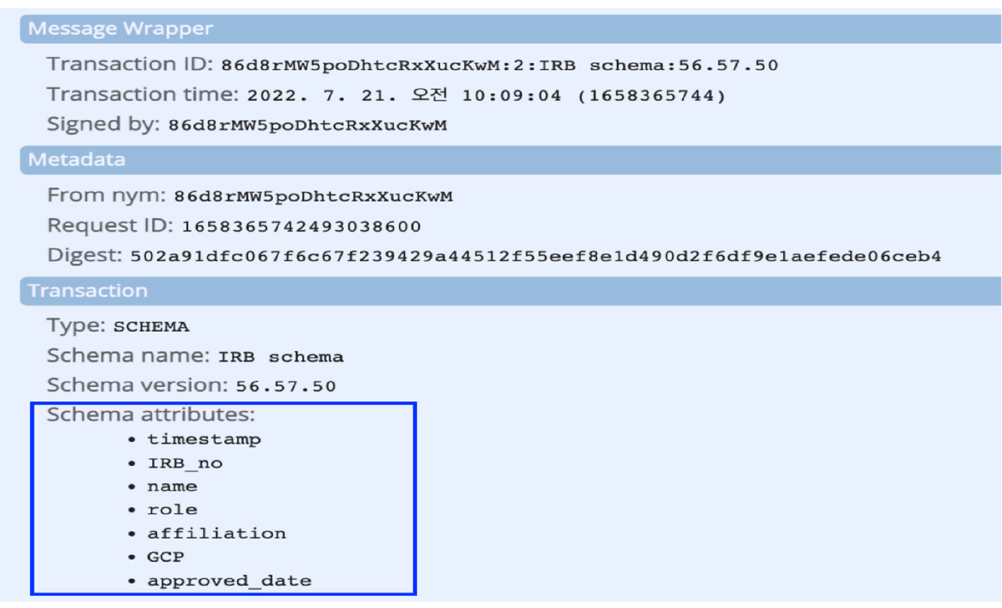
Figure 13. The result of a transaction of a credential schema, which is used for issuing a credential by IRB.